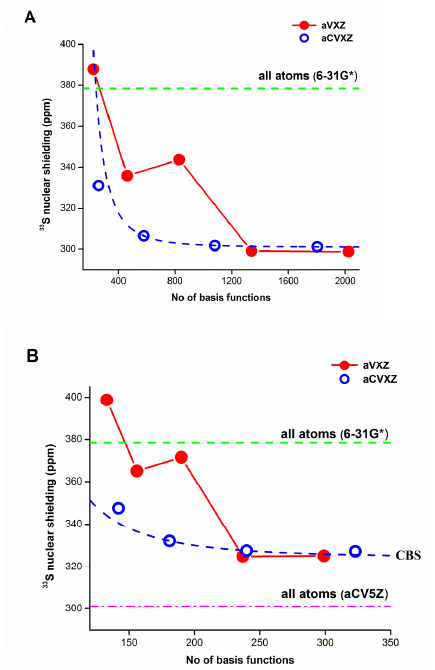
Figure 2. 33 S nuclear isotropic shielding constants of 2-thiouracil calculated at the ( A ) B3LYP/aug-cc-pV X Z and B3LYP/aug-cc-pCV X Z levels of theory, and ( B ) using the LDBS approach, where only the sulfur atom was described using either the aug-cc-pV X Z or aug-cc-pCV X Z and 6-31G* basis set on H, C, N and O atoms. The green dashed line indicates the value obtained at the B3LYP/6-31G* level. The pink dash-and-dot line on the right shows the value obtained at the B3LYP/aug-cc-pCV5Z level (all atoms). 2.3. Corrections to Isotropic Nuclear Magnetic Shieldings of Third Row Elements We compared our best isotropic shieldings for all our molecules that were estimated using the CCSD(T)/aug-cc-pCV X Z data with available literature data in Table 4. It has been documented before that the equilibrium value (calculated for the optimized geom- etry) is often not precise enough, as vibrational effects, thermal effects, or relativistic corrections may become significant, especially for heavier elements [47,48,50,70,71]. Therefore, our CCSD(T)/CBS values were later corrected by the zero-point vibra- tional, thermal and relativistic corrections (the TC and the RC). Thus, the final values were obtained as: final value = equilibrium CCSD(T)/CBS σ + ZPVC + TC + RC. Our cor- rection terms were also compared with available reported corrections (see Table 4). Note, there are no available equilibrium shieldings reported in the literature for NaH, MgH 2 , AlH 3 , H 3 PO, or HSi ≡ CH . Jaszunski et al. performed accurate coupled cluster estimates of